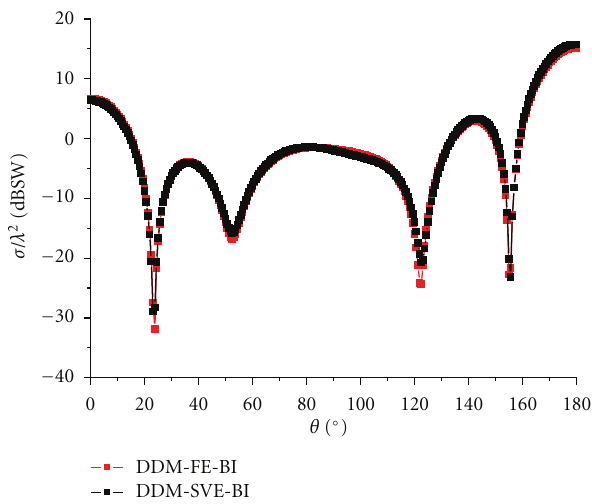
Figure 8: The Bistatic RCS of 3 × 2 array of coating PEC spheres with magnetic material.